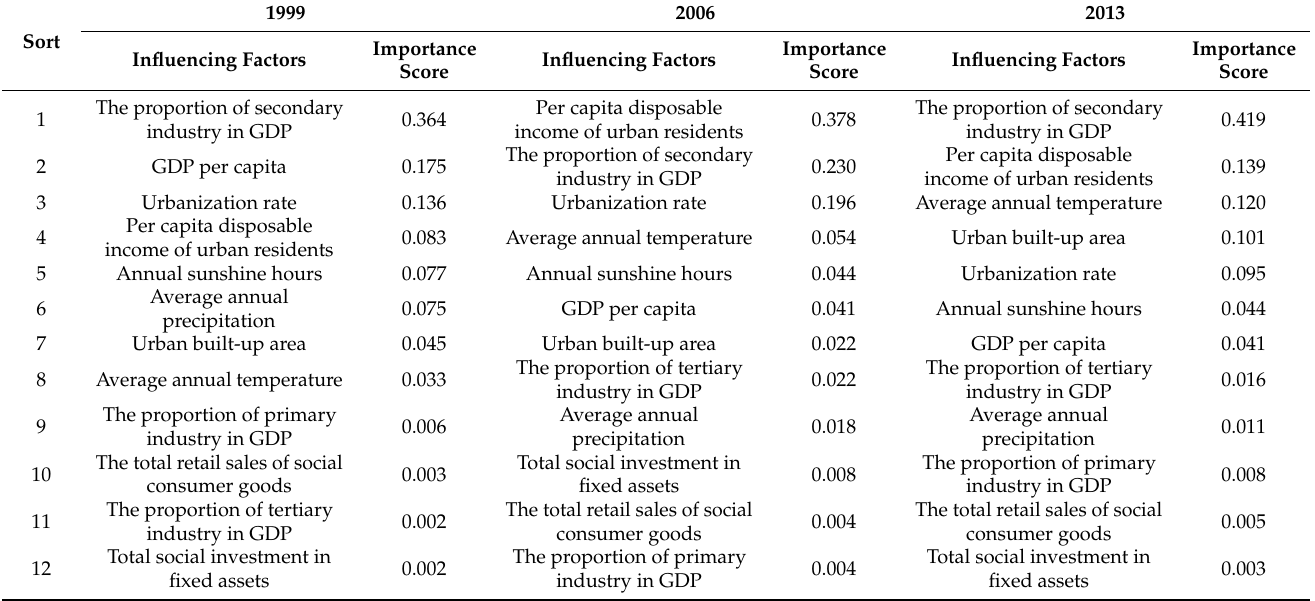
Table 4. Statistical table of the importance scores of the influencing factors of EPC of the three major city clusters in the YREB in 1999, 2006, and